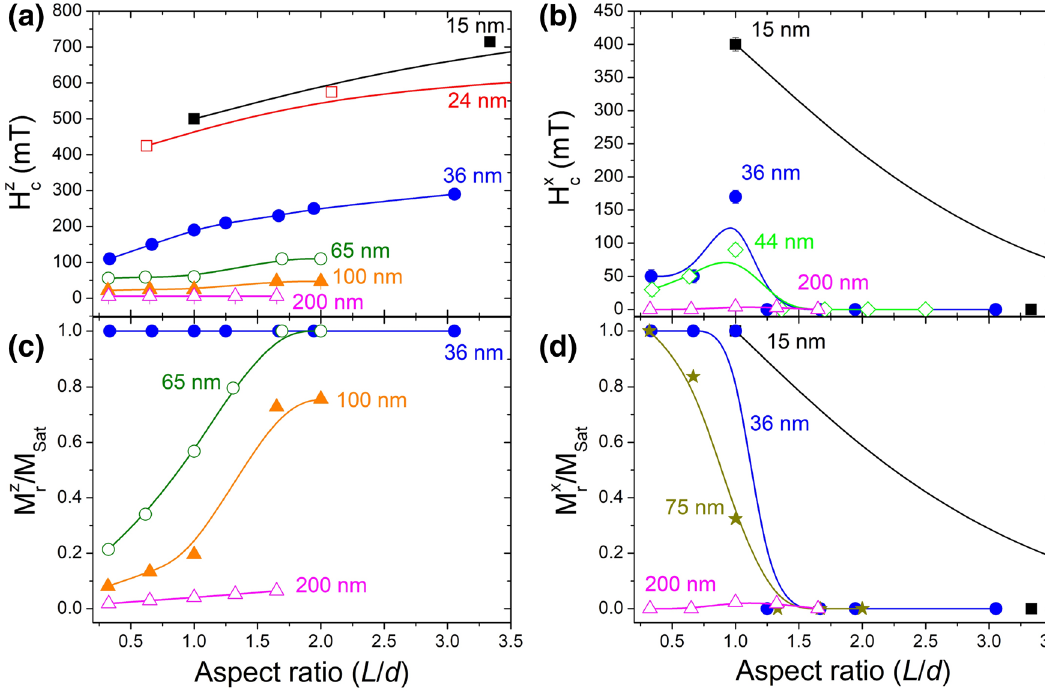
Figure 4. Graphical representations of ( a , b ) the coercivity and ( c , d ) the reduced remanence dependence on the diameter and aspect ratio of selected simulated Ni individual NWs. The magnetic field was applied ( a , c ) parallel and ( b , d ) perpendicular to the NW’s